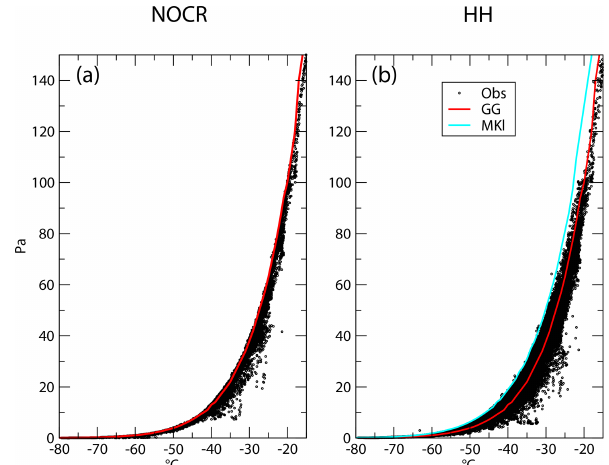
Figure 3. Observed distribution of water vapor versus tempera- ture for 2018–2020, as reported by standard instruments such as the HMP155 (a) and systems adapted to report supersaturation (b) . The red line (GG) shows the Clausius–Clapeyron relation for the satu- ration partial pressure wri as calculated using the Goff and Gratch (1946) formulation, similar to Fig. 2 but shown here with a linear y axis. The blue curve shows the equilibrium partial pressure over liquid water according to Murphy and Koop (2005) (MKl).